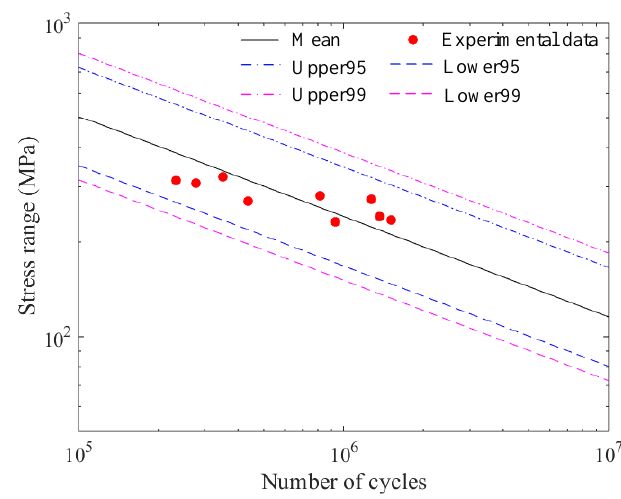
Figure 13. Experiment verification of the master S-N curve for the orthotropic steel decks (OSD).